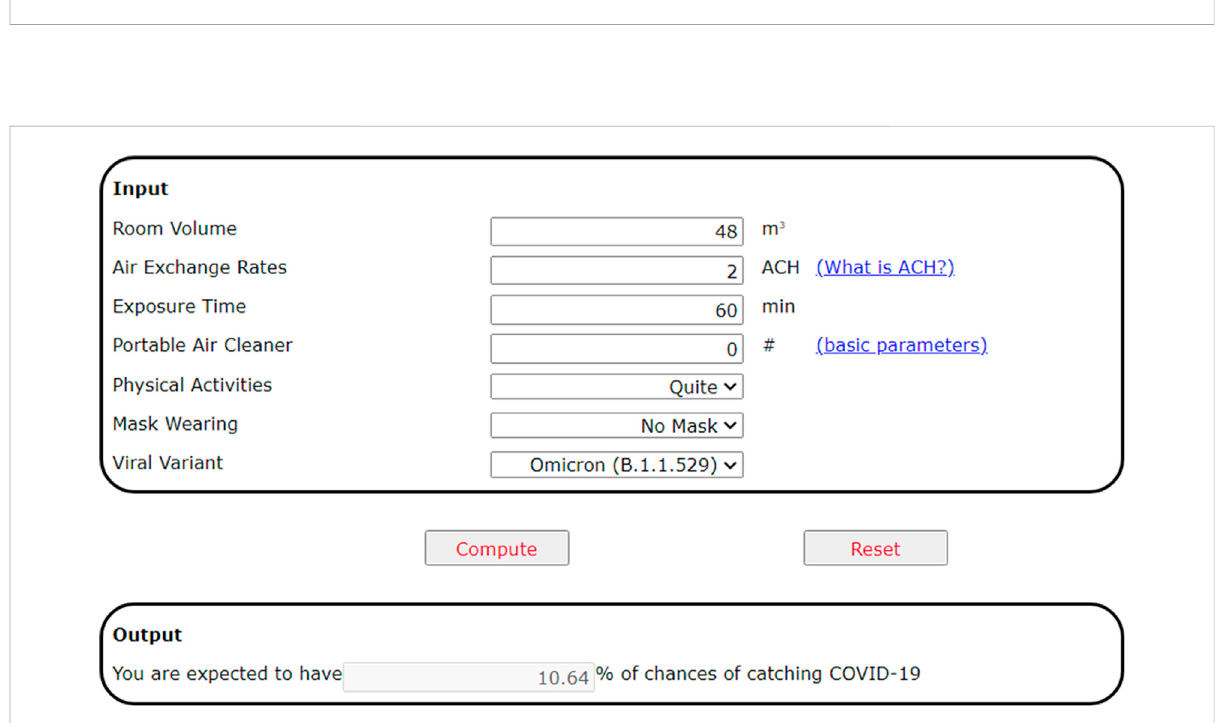
The web-based calculator of COVID-19 transmission risks in an indoor space, accessible at https://www.arch.hku.hk/research_project/covid-